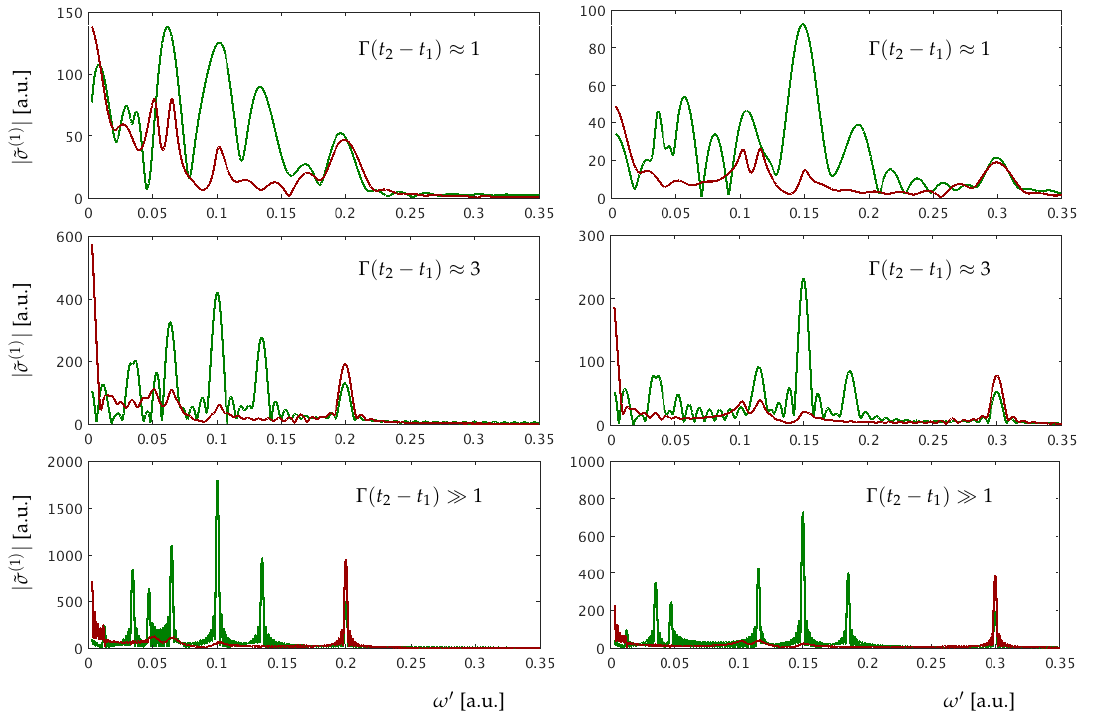
Figure 7. Fourier spectra at ω = E 1 − − E 0 + (green line) and ω = E 1 + − E 0 + + ω d (red line) for different pulse durations of the dressing field ( Γ is kept constant). The pulse durations used are integers of the dressing field period. Left and right panels correspond to the dressing photon energies ω d = 0.10 a.u. and ω d = 0.15 a.u.,